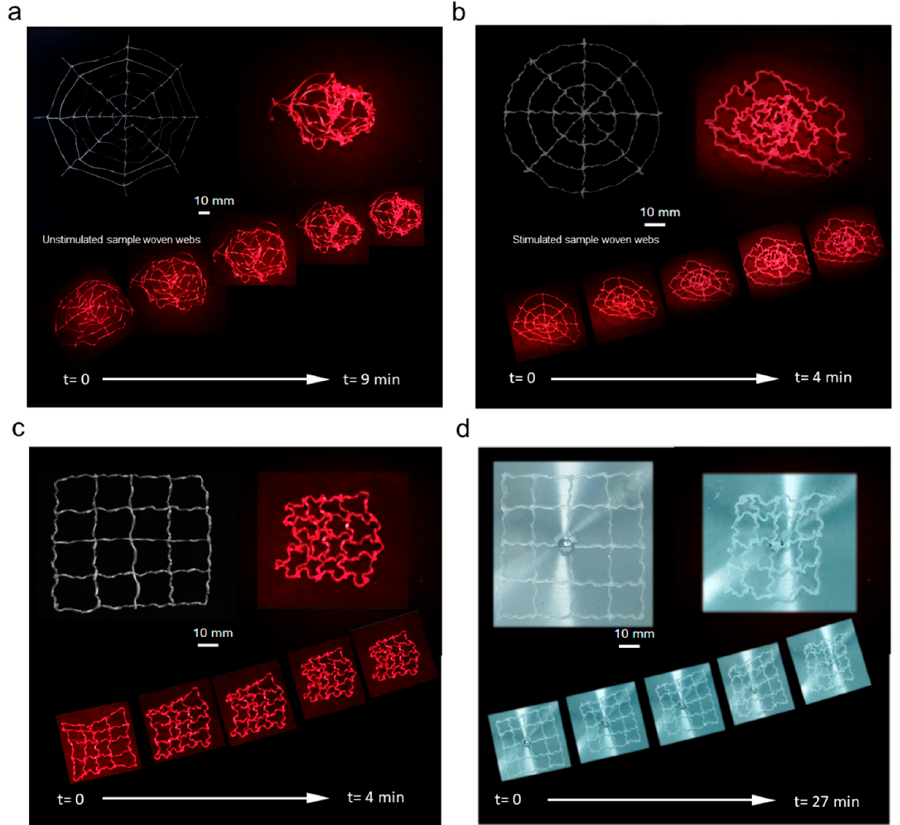
Figure 8. Stimulated deformation of the unstimulated spider webs made of bio-inspired spider silk ( a ); stimulated deformation of the webs made of bio-inspired spider silk stimulated at high temperature ( b ); stimulated deformation of square bio-inspired spider webs stimulated by infrared light ( c ); stimulated deformation of square bio-inspired spider webs stimulated by humidity ( d ).